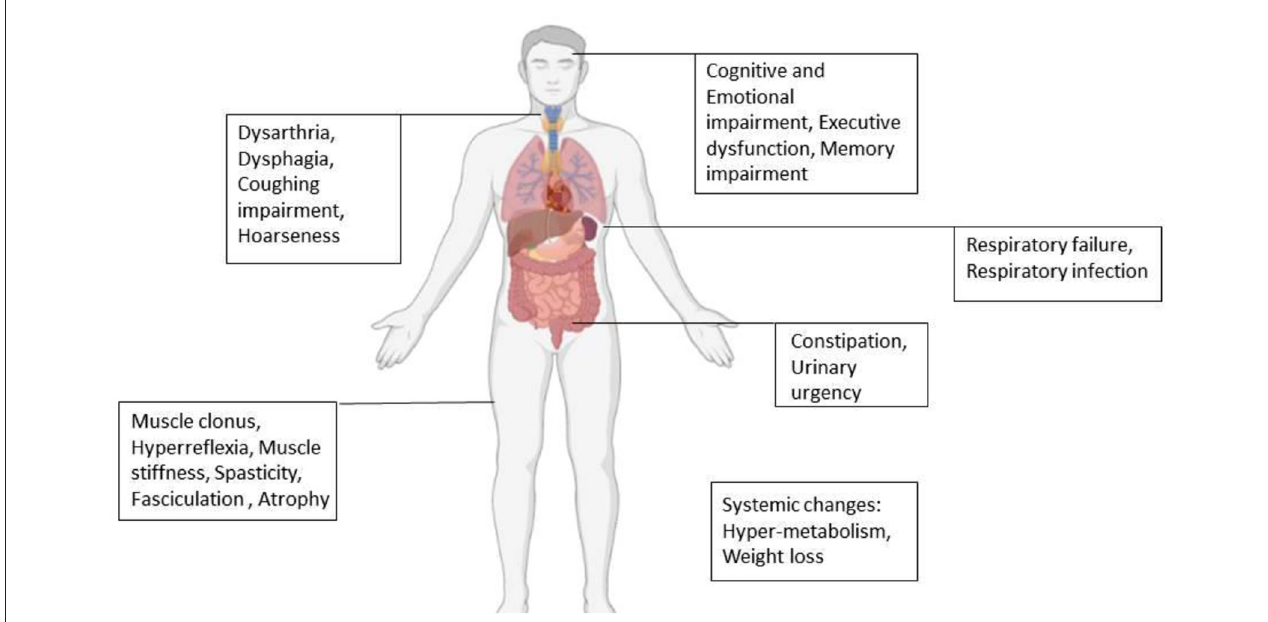
FIGURE 2 | Motor, non-motor, and systemic changes in ALS (21,